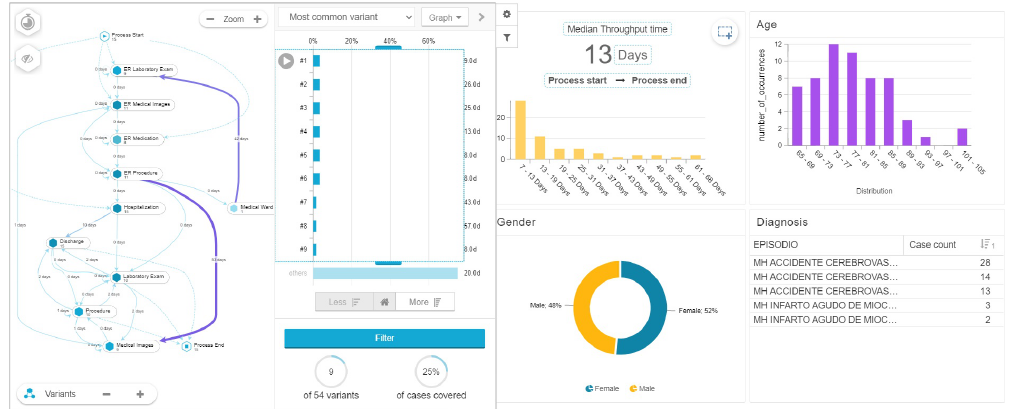
Figure 11. Variant and extended stay for AMI